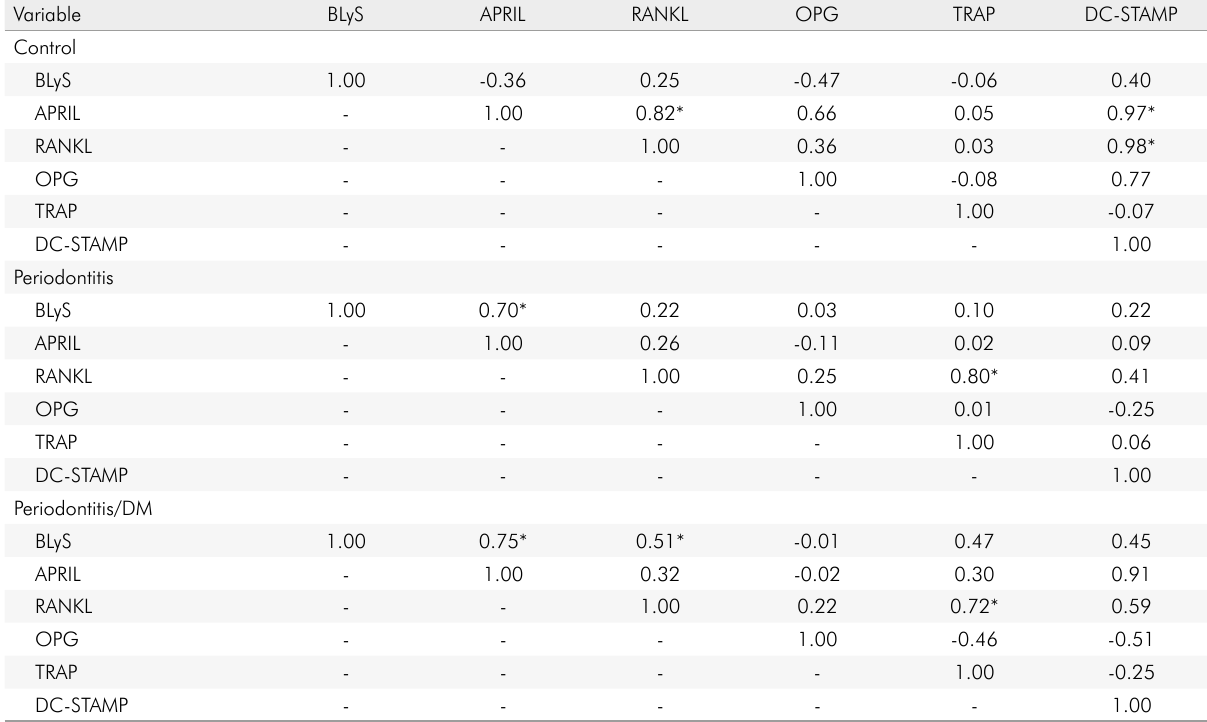
Table 3. Correlation coefficients among all biomarkers at mRNA